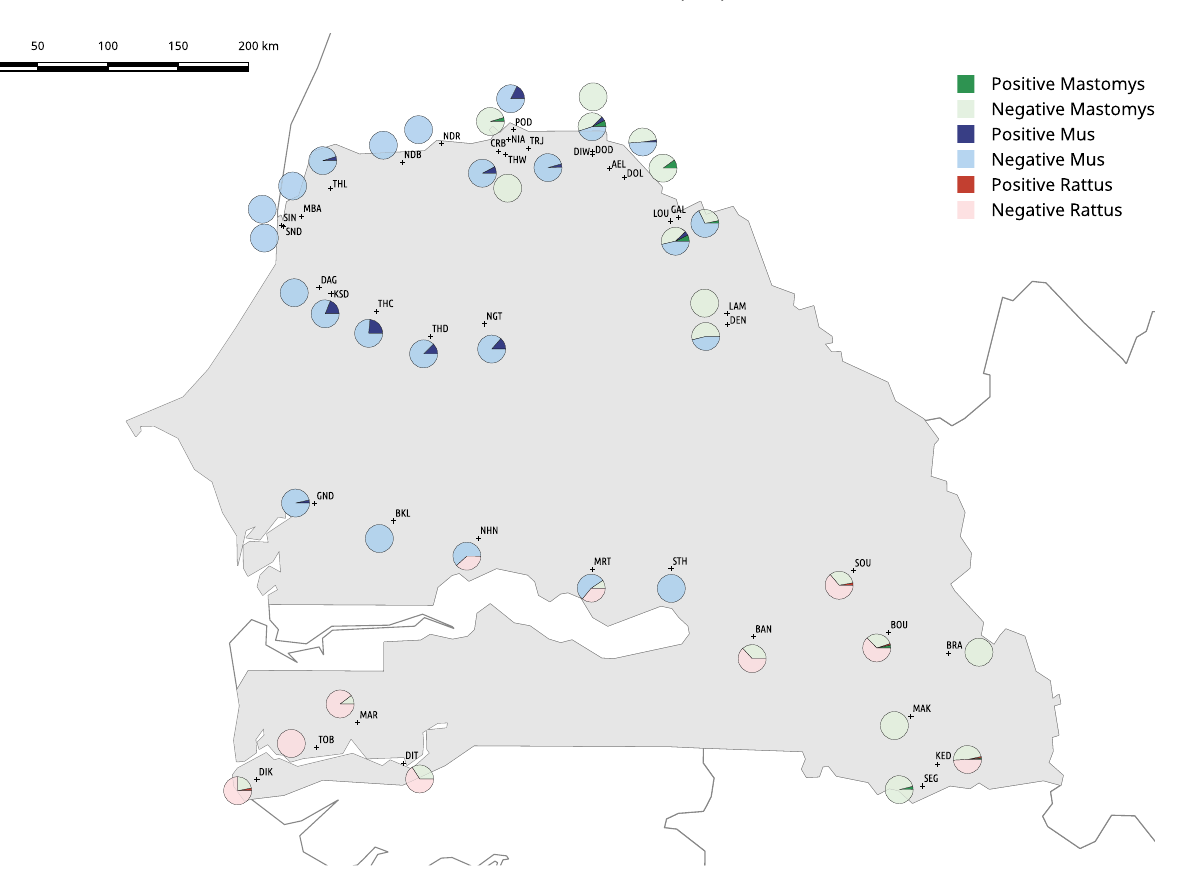
Fig. 1. Seroprevalence of Toxoplasma gondii in rodent communities in villages and towns in Senegal. See Table 1 for locality codes. Light and dark colours indicated the percentage of negative ( (cid:2) ) and positive (+) rodents of each dominant species in the community ( Mus musculus , Rattus rattus or Mastomys spp.),